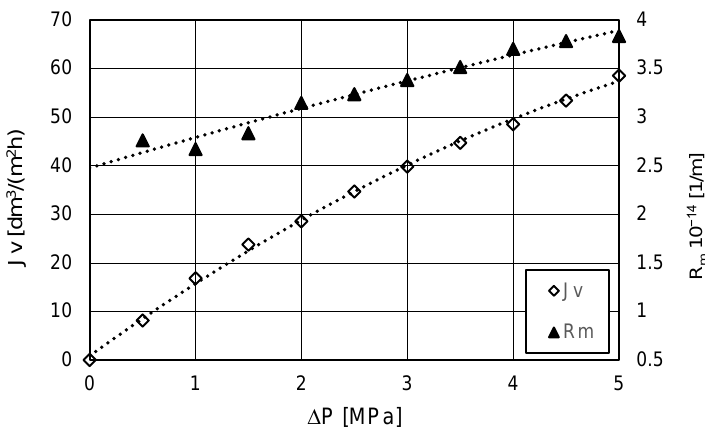
Figure 7. Permeate flux and the total flow resistance to the fluid flowing through the membrane ( R m ) vs. pressure in the RO experiment conducted using the AG Osmonics membrane. The second stage of the integrated treatment process, i.e., the reverse osmosis of the model wastewater containing either an anionic (A-S8) or a nonionic (N-S7) surfactant, was carried out at a pressure of 3 MPa. The observed changes in flux with time are shown in Processes 2021 , 9 , x FOR PEER REVIEW 11 of 16 Figure 8.